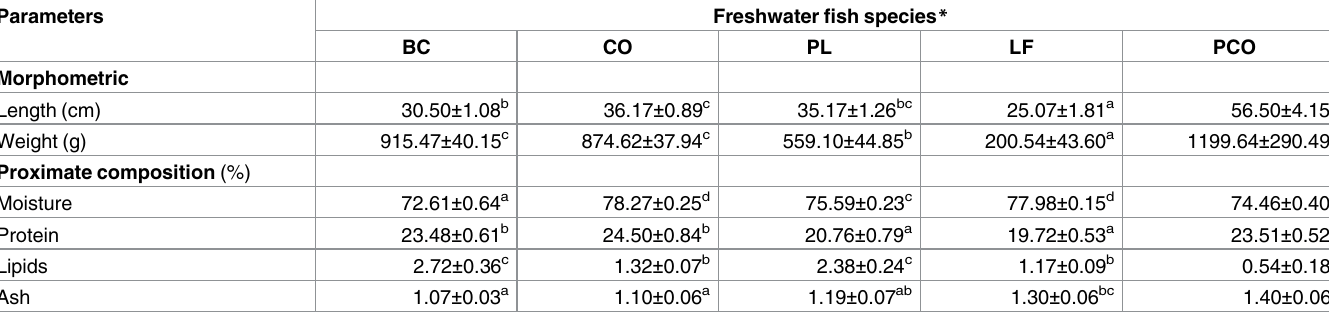
Table 1. Morphometric data and proximate composition of the five Brazilian freshwater fish species evaluated